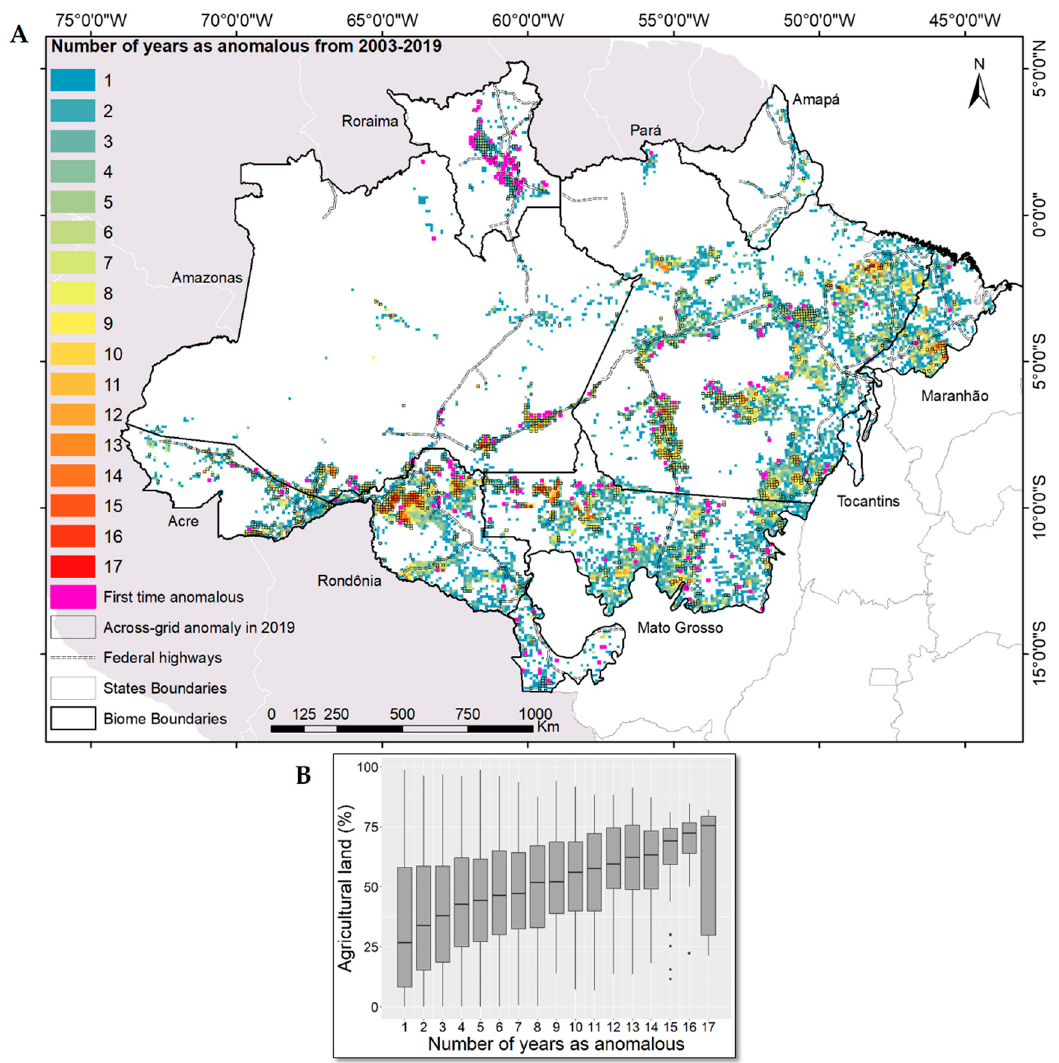
Figure 5. ( A ) The number of years each cell in the grid was considered across-grid fire anomalous from the period of 2003–2019. Cells that were across-grid fire anomalous for the first time in 2019 are filled with magenta, while the remaining across-grid fire anomalous cells in 2019 are highlighted in black. ( B ) Boxplots showing the relationship between the number of years a cell was considered across-grid anomalous and the percentage of agricultural land (pasture or cropland) in the cell in 2018. The agricultural area of each cell was calculated over the area of agricultural plus natural vegetation cover (forest, savanna, shrubland, and grassland, except for mangroves).